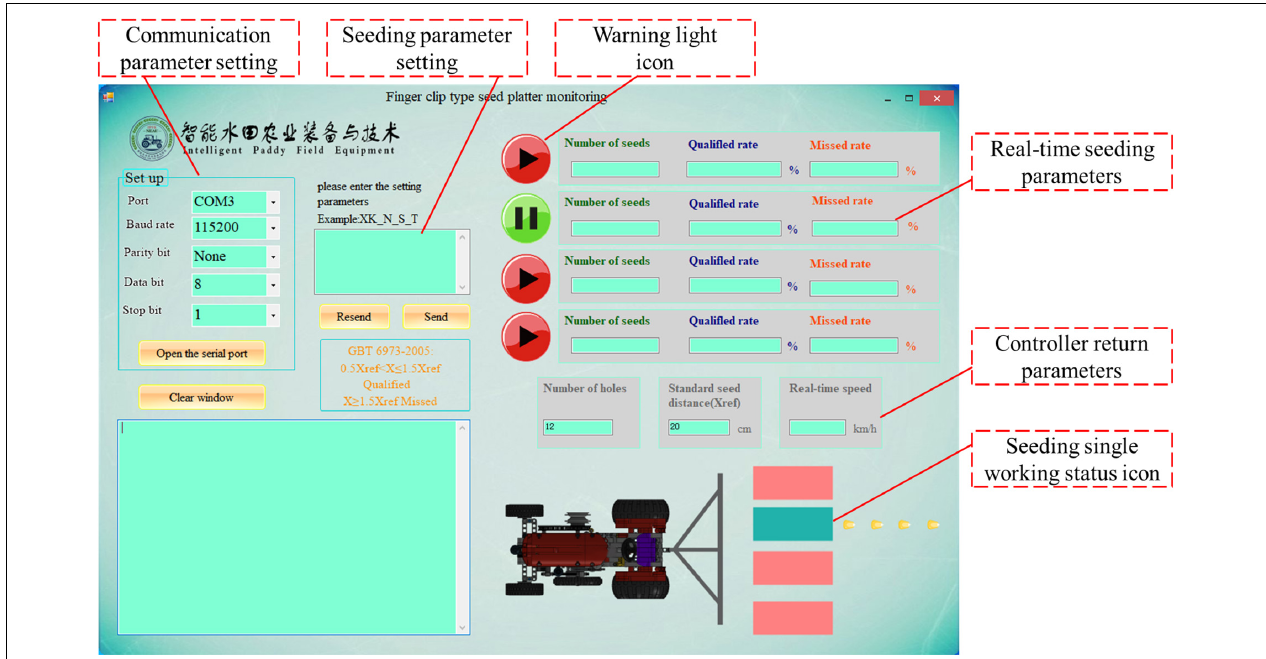
FIGURE 7 | Software